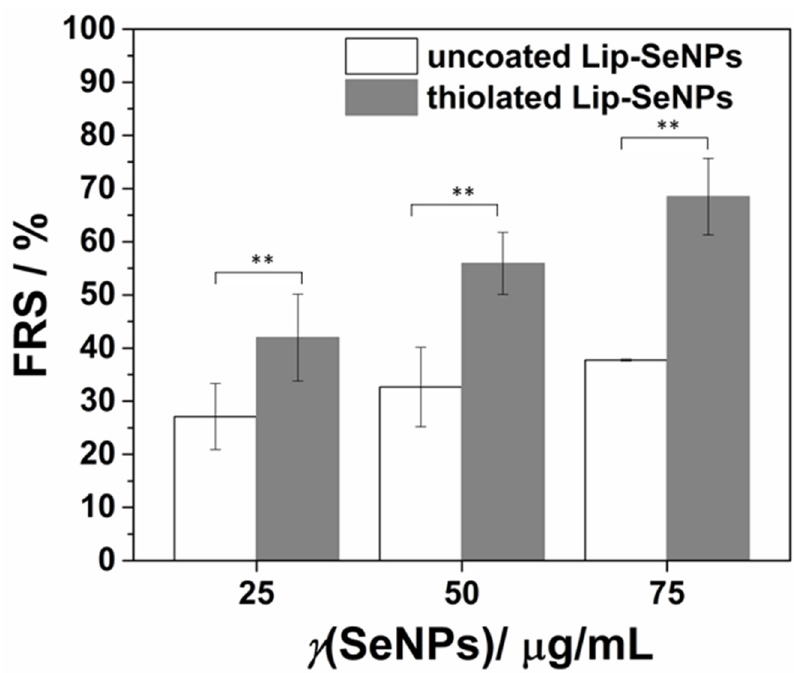
Figure 6. Free radical scavenging (FRS) ability of Lip-SeNPs. The values are expressed as mean values ± SD ( n = 3); unpaired t -test, ** p < 0.01.